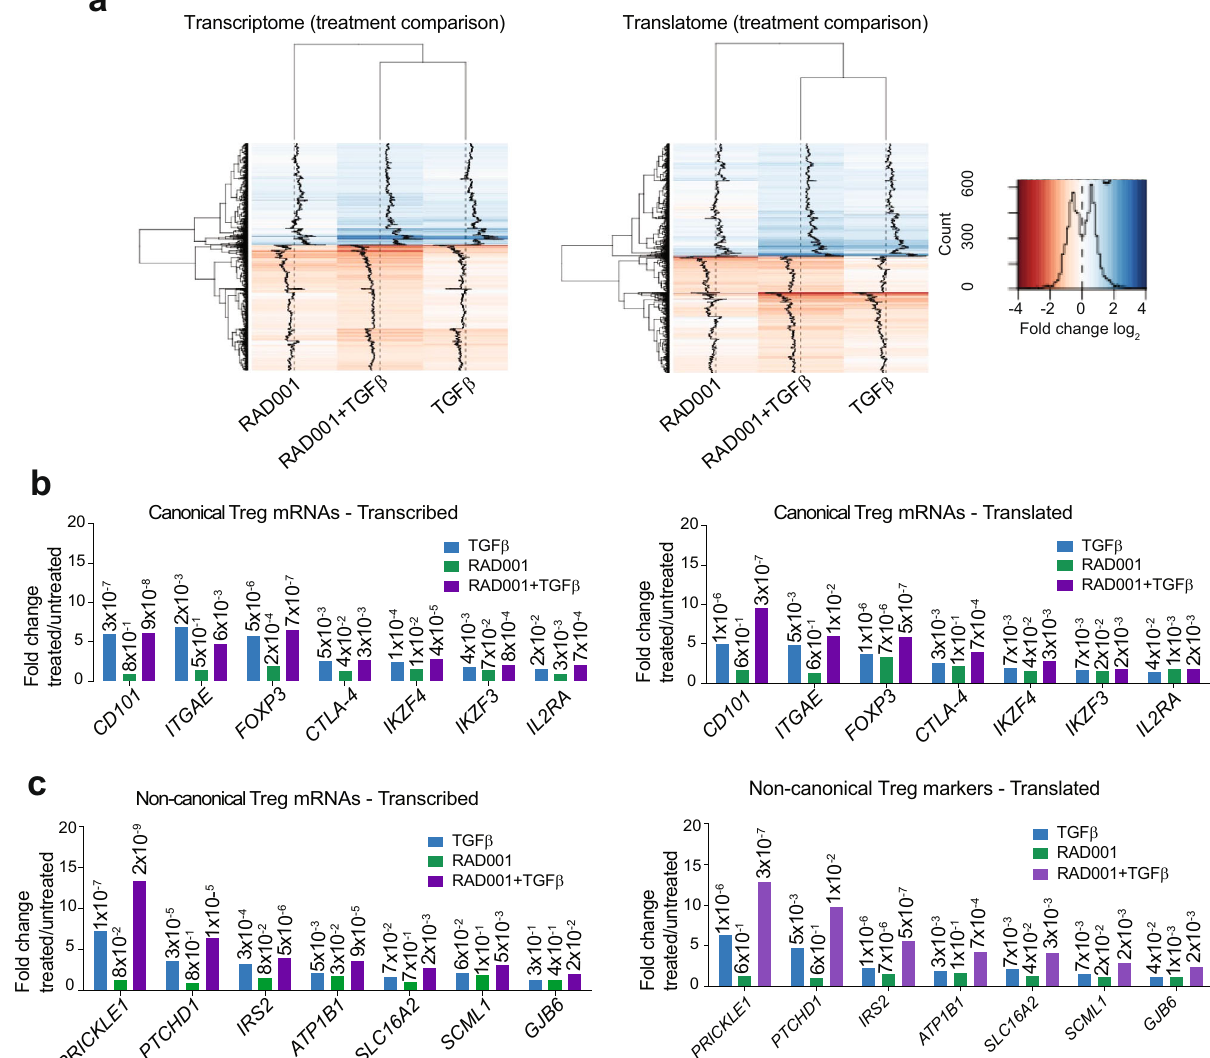
Fig. 6 mTORC1 inhibition and TGF-beta treatment selectively promotes translation of canonical Treg cell mRNAs. a Heat map of genes and mRNAs upregulated or downregulated in CD4 + T cells treated with RAD001 + TGF-beta compared with single treatments. RAD001 + TGF-beta treatment increases the extent of upregulation or downregulation of each gene/mRNA compared with single treatments. Log 2 of fold-changes of genes/mRNAs in TGF-beta, RAD001, and RAD001 + TGF-beta compared with untreated controls were used to generate heat maps for genome-wide mRNA abundance (left panel) and translation of mRNAs (right panel). Each row corresponds to a gene/mRNA. Blue indicates upregulation, red downregulation. Darker shades correspond to higher log 2 fold-change values. b Treg cell canonical mRNA levels are upregulated by TGF-beta and increased in translation by mTORC1 inhibition. Transcription and translation levels of genes/mRNAs characterizing the Treg cell population are shown for each treatment, each bar representing the fold- change against untreated. P values are shown on top of each histogram derived from genome-wide analysis (analyzed fi ltered source data provided in Supplementary Data 2 – 8). c Non-canonical mRNAs with activities associated with Treg cell development or function are increased in expression by TGF- beta and translation by mTORC1 inhibition. IPA software analysis tools calculated P values as shown above each histogram. a Data represent compiled analysis of genome-wide data from three donors, two replicates each. Data analysis ( b and c ) by IPA used a suite of bioinformatics and statistical analysis tools, including right-tailed Fisher ’ s exact tests to determine P values and Benjamin – Hochberg corrections for multiple